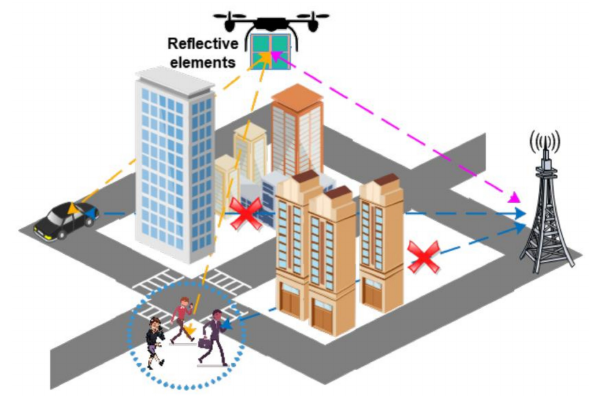
Figure 2. IRS-assisted UAV communication